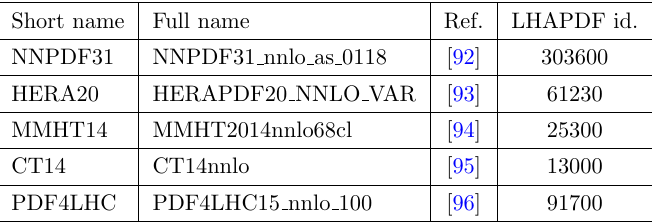
Table 4 . List of collinear PDF used as the boundary for unpolarized